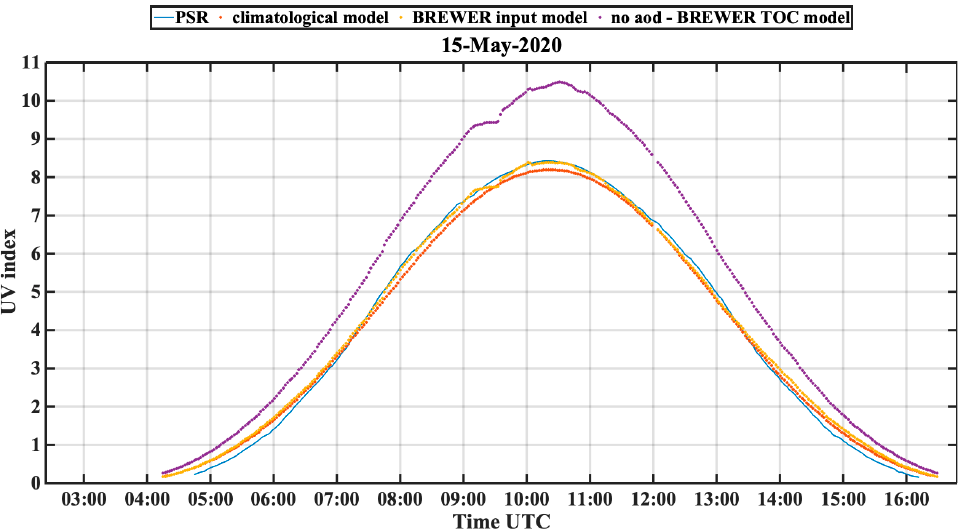
Figure 6. Diurnal variation of UVI on 15 May 2020 as retrieved from the PSR measurements, in comparison with modeled UVI predicted using: RTM with climatological TOC and AOD inputs, BRS AOD and TOC, BRS TOC without aerosols.